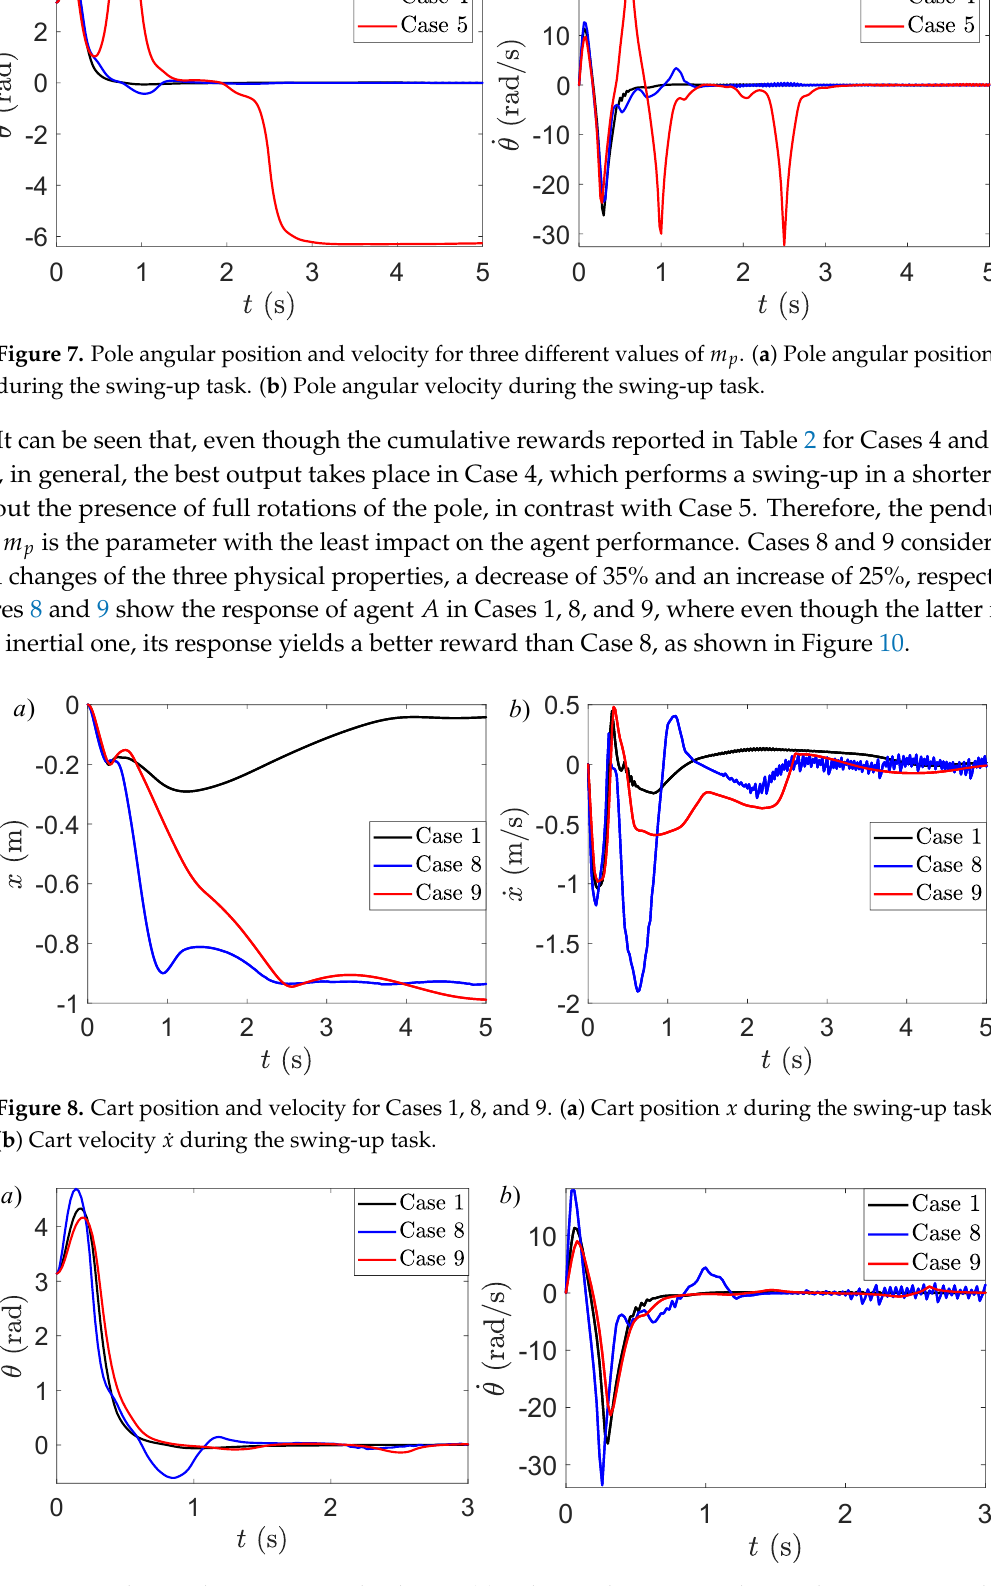
Figure 9. Pole angular position and velocity. ( a ) Pole angular position during the swing-up task. ( b ) Pole angular velocity during the swing-up